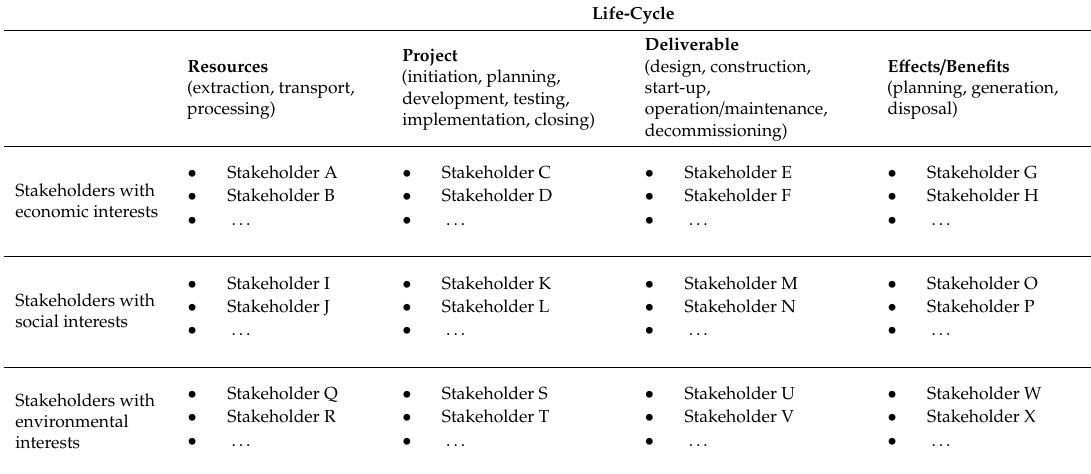
Table 5. Framework for a structured identification of stakeholders from a sustainable development